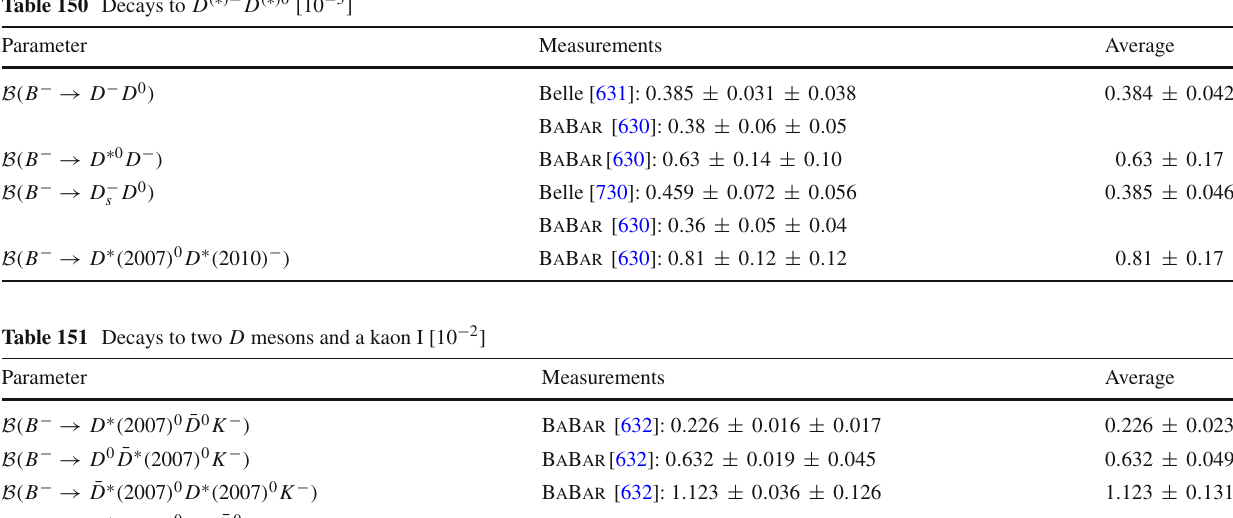
Table 150 Decays to D ( ∗ ) − D ( ∗ ) 0 [ 10 − 3 ]